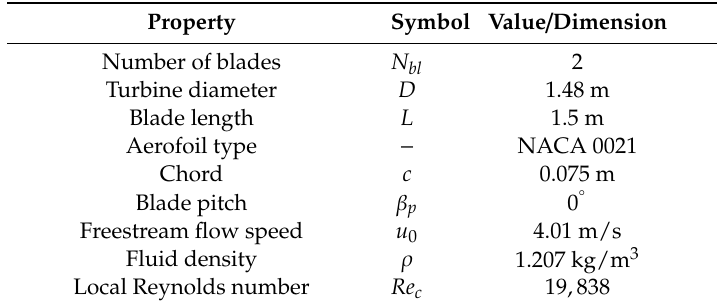
Table 1. VAT model parameters based on the experimental turbine configuration at Delft